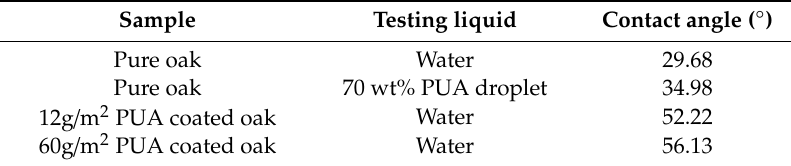
Table 5. Contact angles of PUA droplets (70% solids) and water on the oak surface.